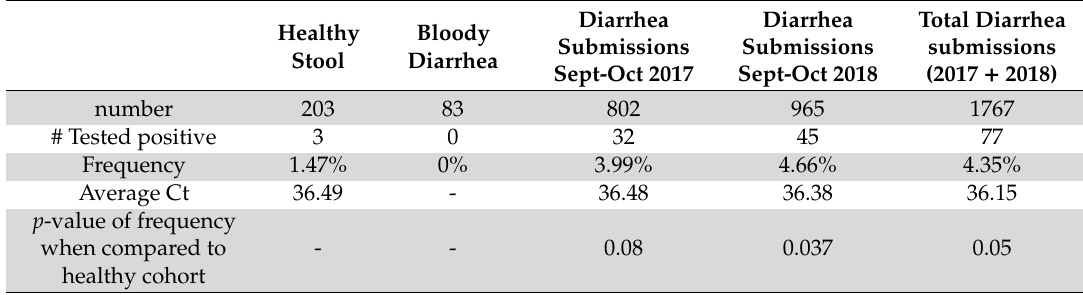
Table 1. Real-time PCR results of cachavirus from four cohorts. A total of 2,053 samples were tested. Healthy Bloody Stool